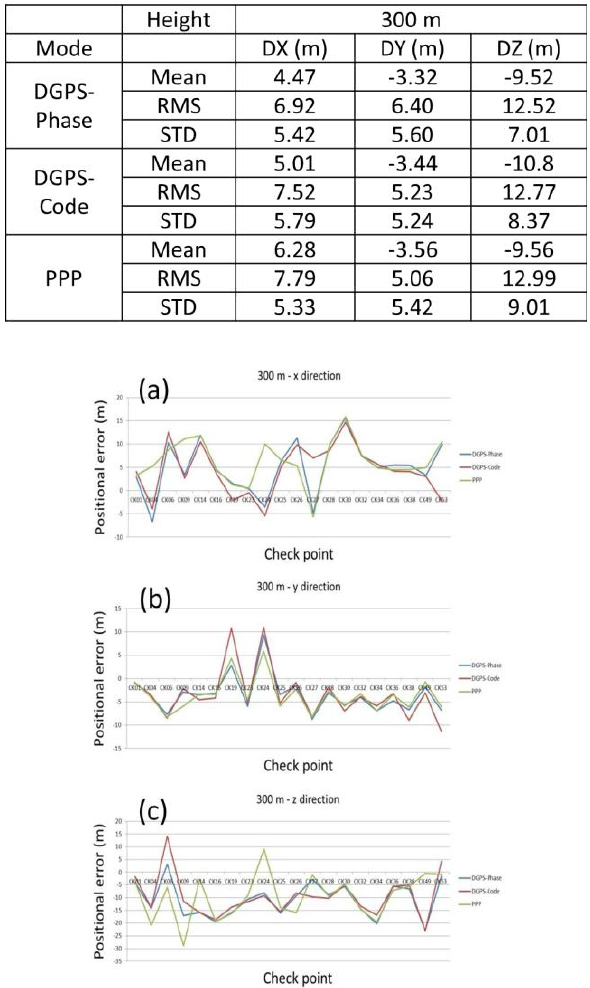
Figure 9. Error in (a) X; (b) Y; (c) X direction with 300